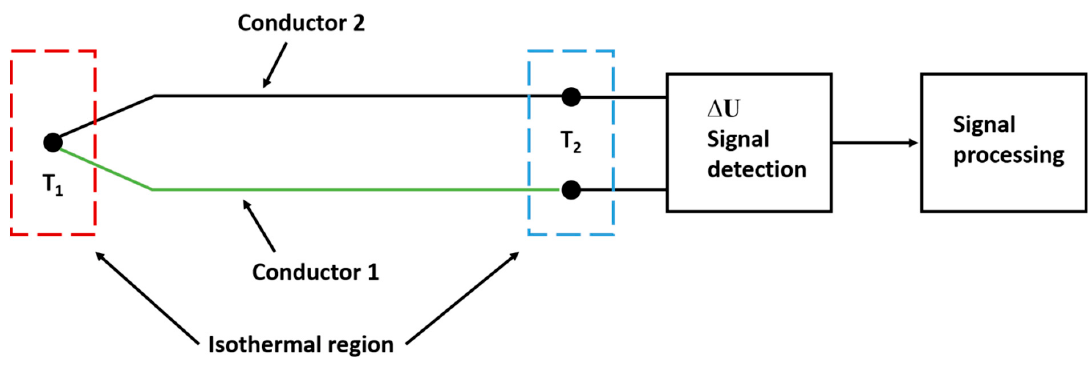
Figure 1. The model of thermocouple detection and signal processing according to [13].